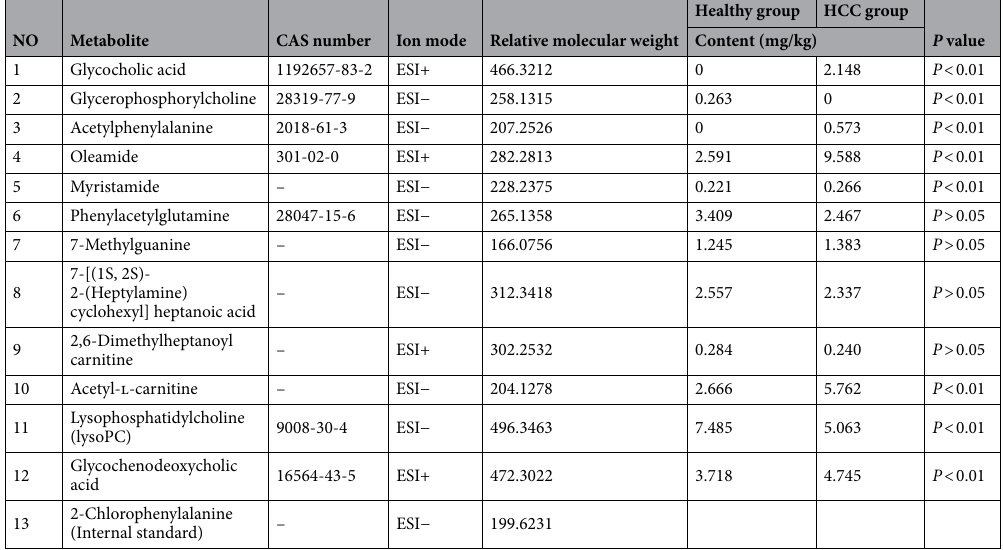
Table 2. List of reference standards and content and difference analysis of compounds in different group. Compared with healthy group significant difference, P is 0.01 < P < 0.05 for the significant difference, P < 0.01 for the extremely significant difference, P > 0.05 for no